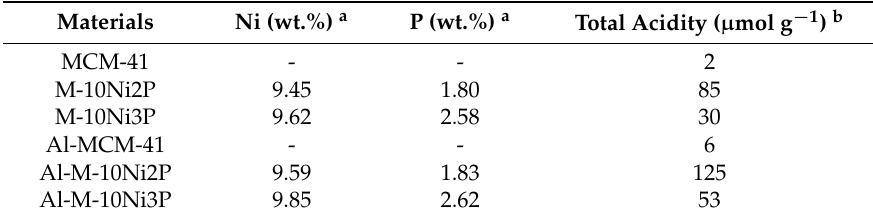
Table 2. Elemental contents and total acidity of the synthesized materials .